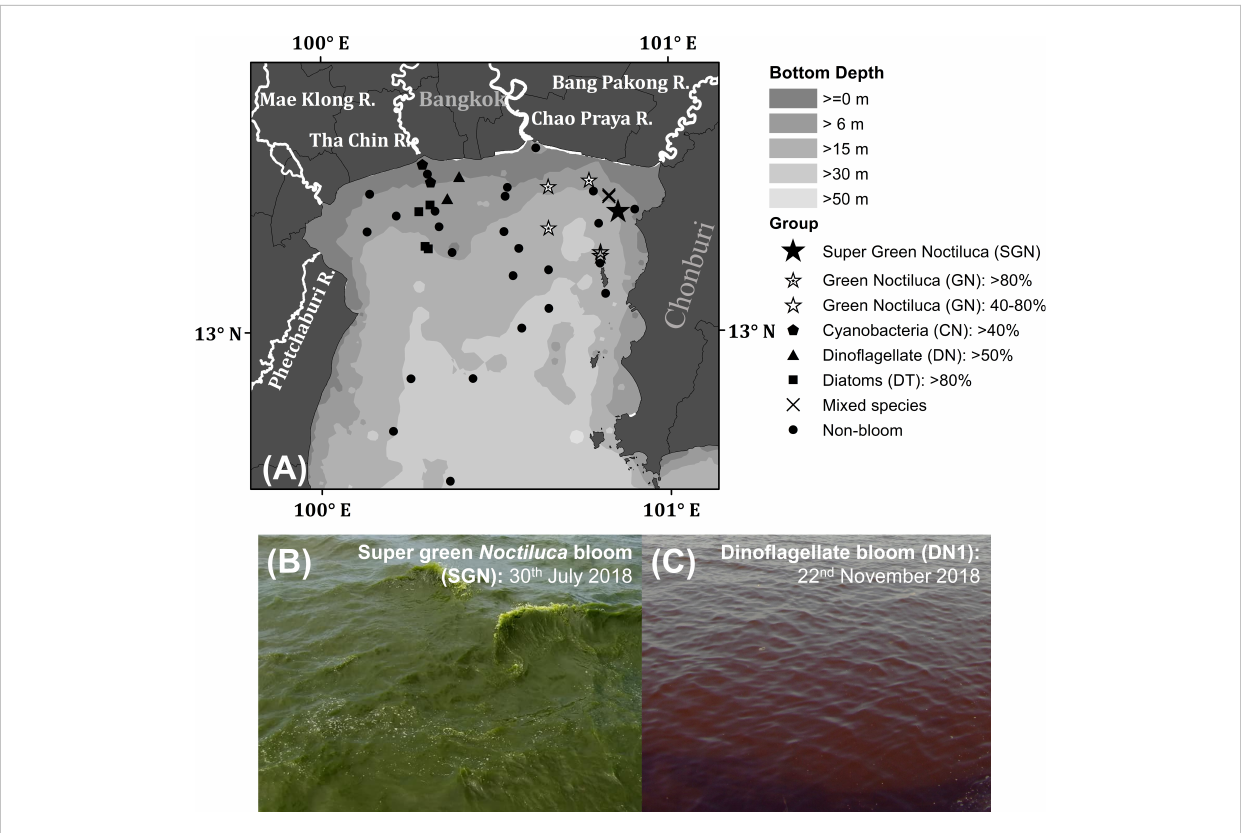
FIGURE 2 Map of sampling stations in the uGoT (A) and photos of the sea surface during super green Noctiluca (B) and dino fl agellate Ceratium furca (C) blooms. The symbols in (A) indicate water types during ship